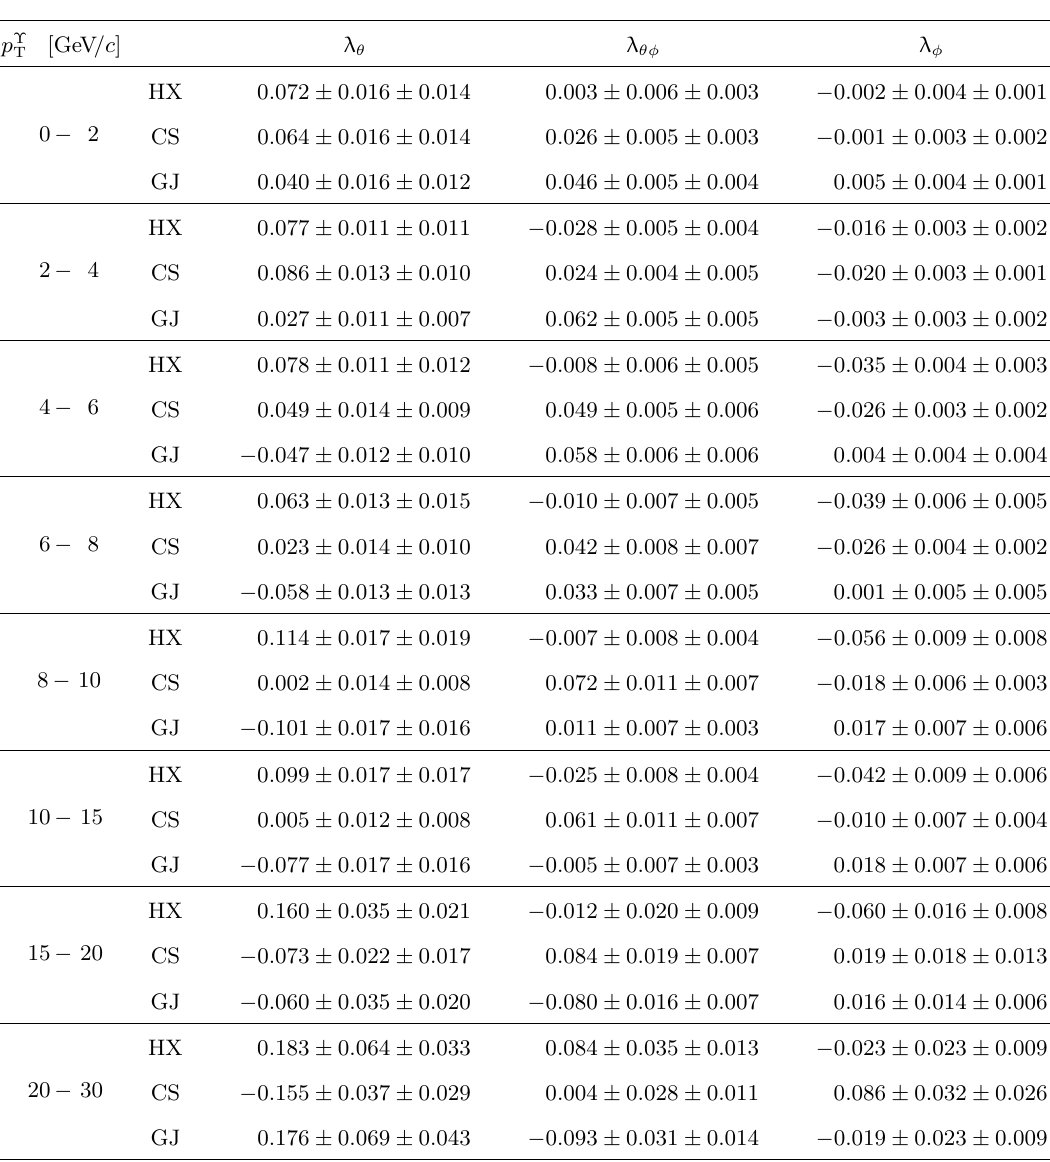
Table 9 . Values of (cid:21) (cid:18) , (cid:21) (cid:18)(cid:30) and (cid:21) (cid:30) measured in the HX, CS and GJ frames for the (cid:7)(1S) produced p at s = 8 TeV in the rapidity range 2 : 2 < y (cid:7) < 4 : 5. The (cid:12)rst uncertainty is statistical and the second